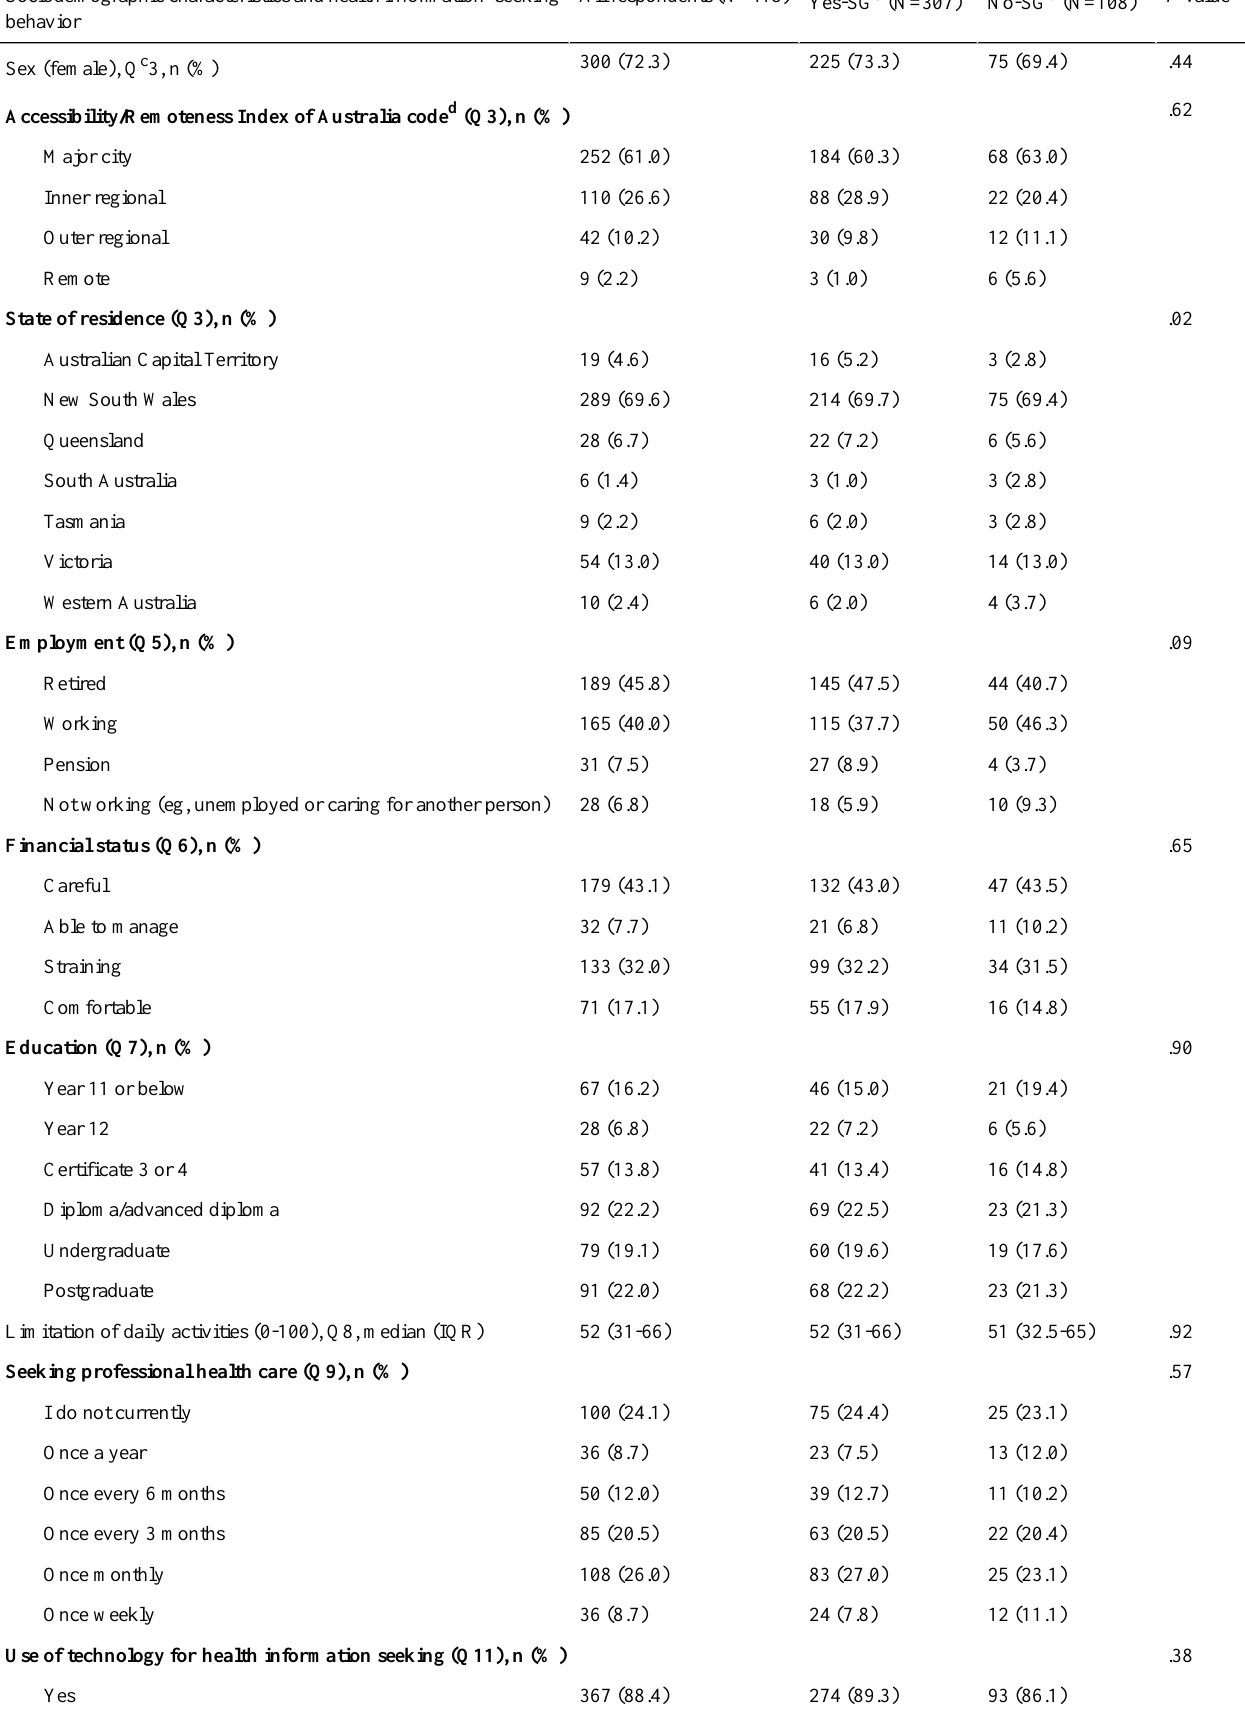
Table 1. Sociodemographic characteristics and health care– and health information–seeking behavior of the survey